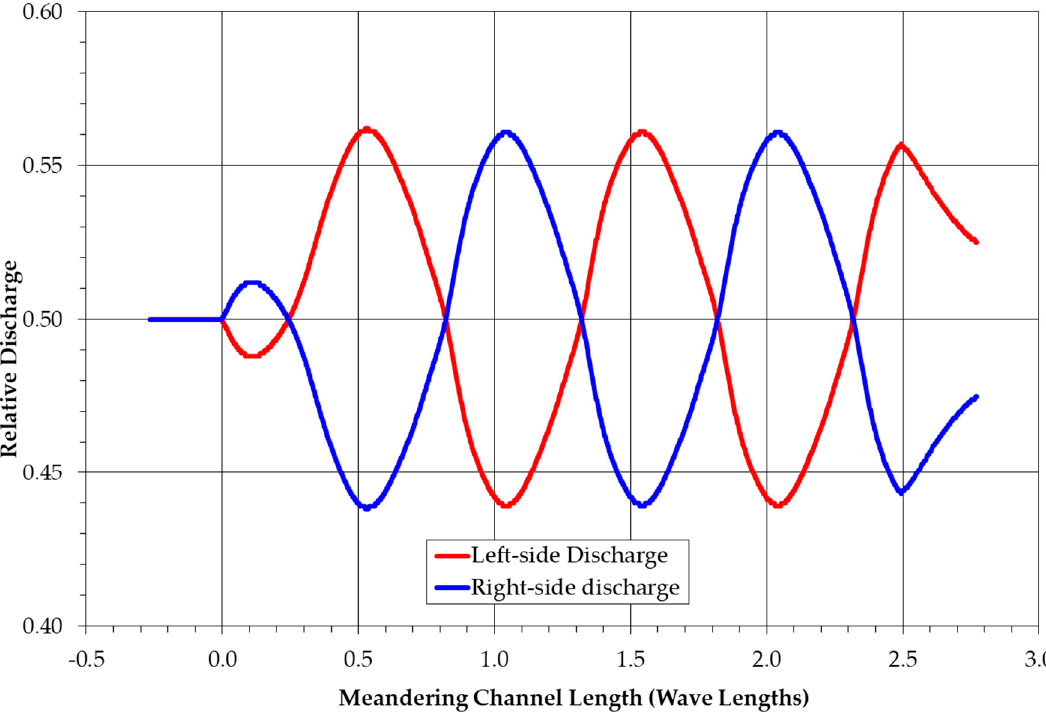
Figure 21. Relative discharge on the left and right sides of the channel centerline through five consecutive meander bends. Table 3. CSU physical model dimensions.